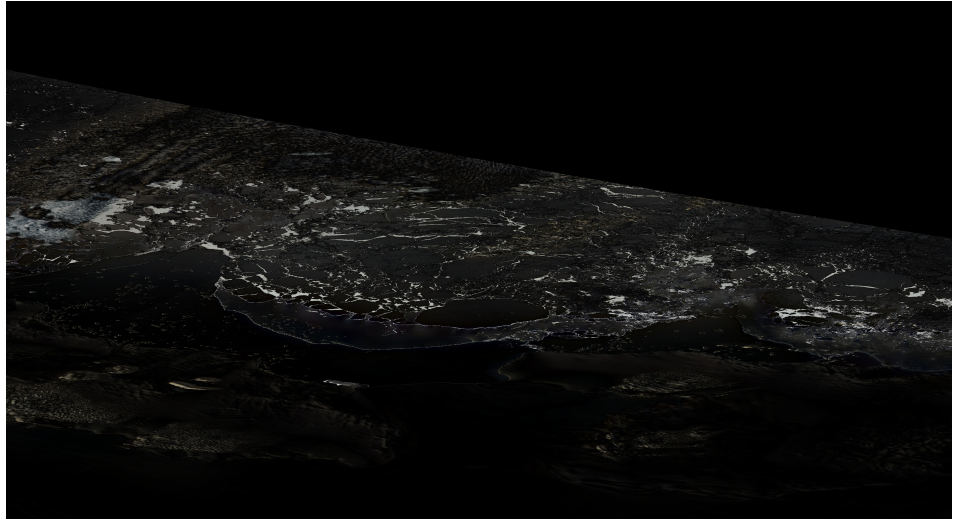
Figure 7. Example of a “no light”